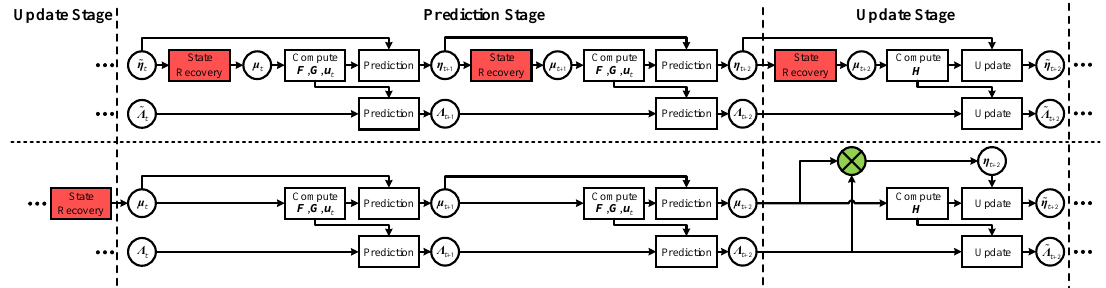
Figure 4. Comparison of the typical form and our hybrid form prediction. Different processing steps between these two forms are marked with different colors depending on their computational